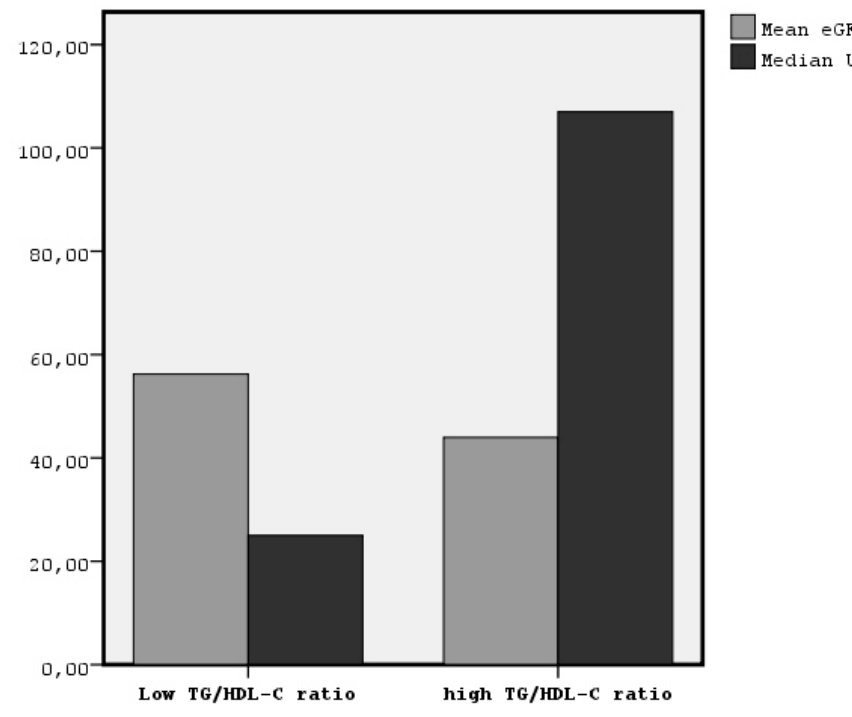
Figure 1. The comparison between the high and low TG / HDL-C ratio regarding both eGFR and UACR (mean ± SD 43.9 ± 20 vs. 58.8 ± 22.1 ( p = 0.001) and mean rank 107.1 vs. 80.0 ( p = 0.001), respectively).